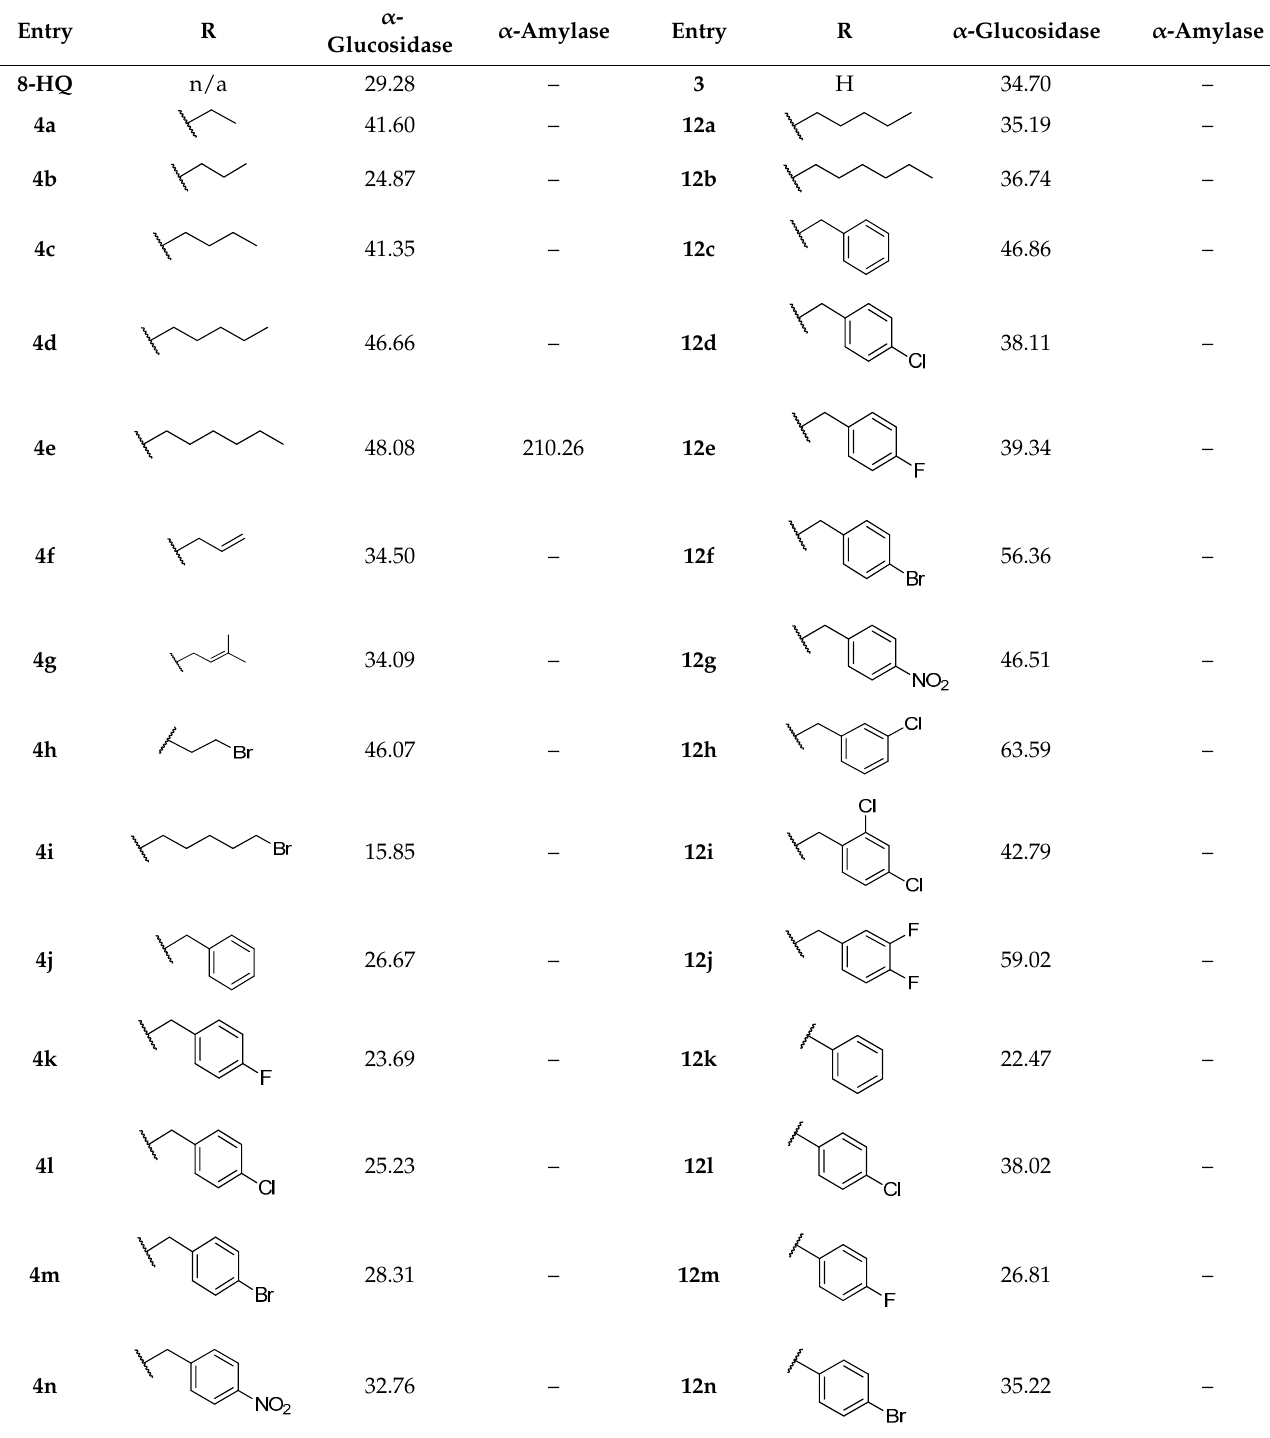
Table 2. IC 50 ( µ M) for α -glucosidase and α -amylase inhibition by compounds 4a – t and 12a – t .